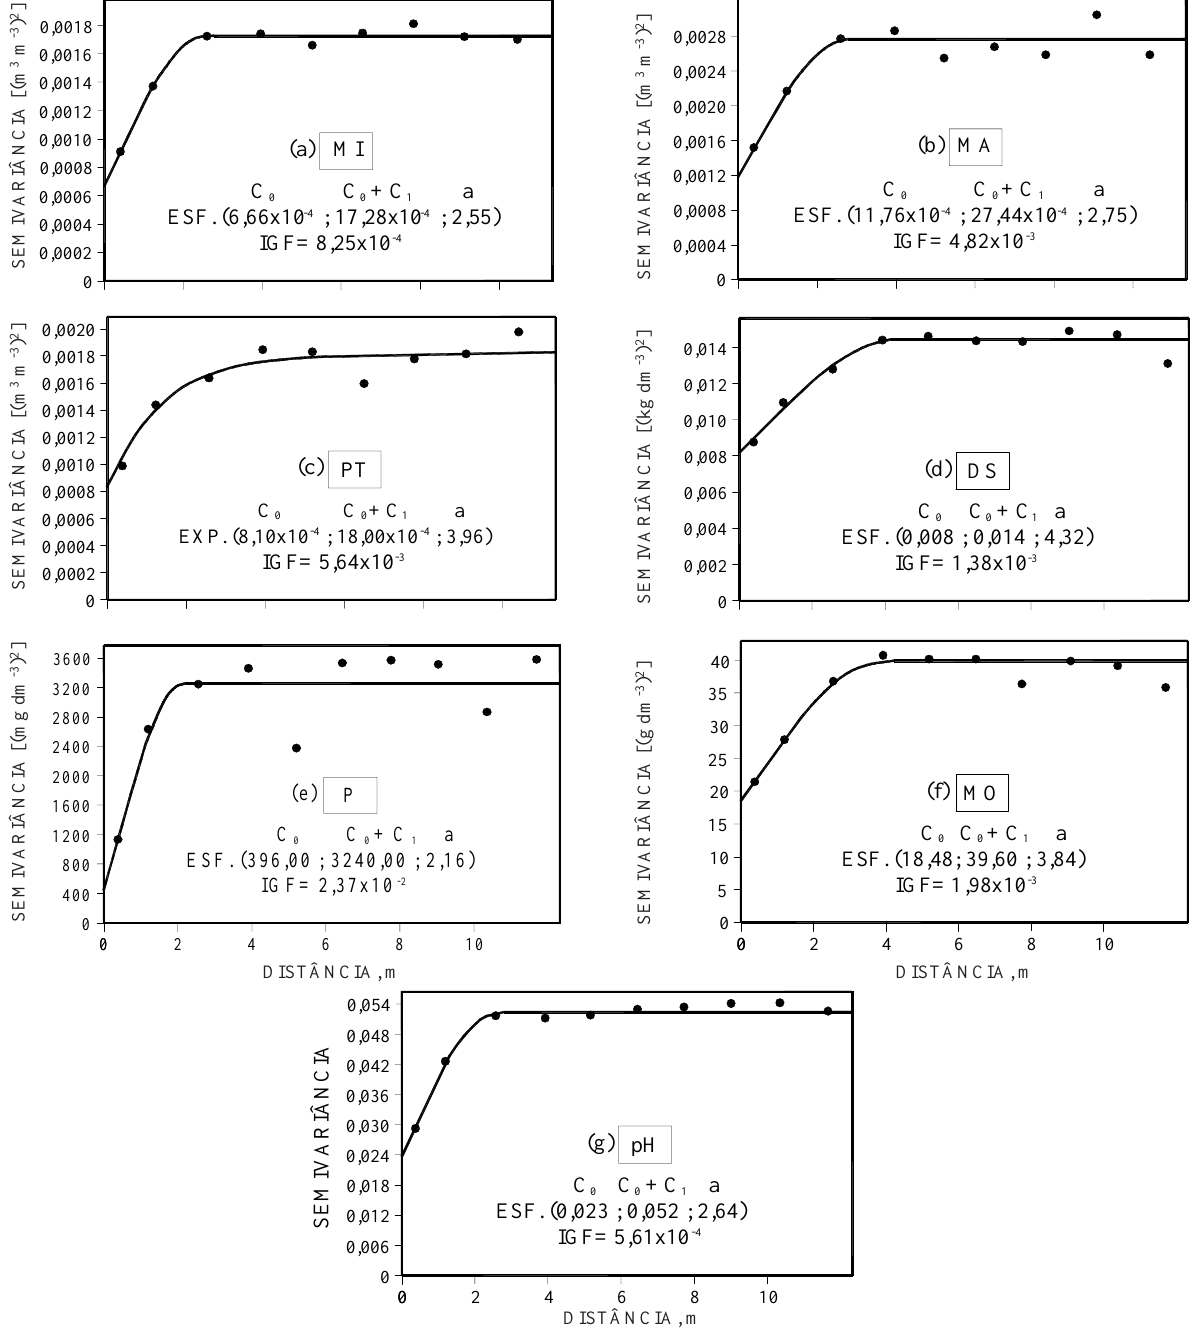
Figura 1. Semivariogramas dos atributos do solo: (a) microporosidade, (b) macroporosidade, (c) porosidade total, (d) densidade do solo, (e) fósforo disponível, (f) matéria orgânica e (g) pH em CaCl